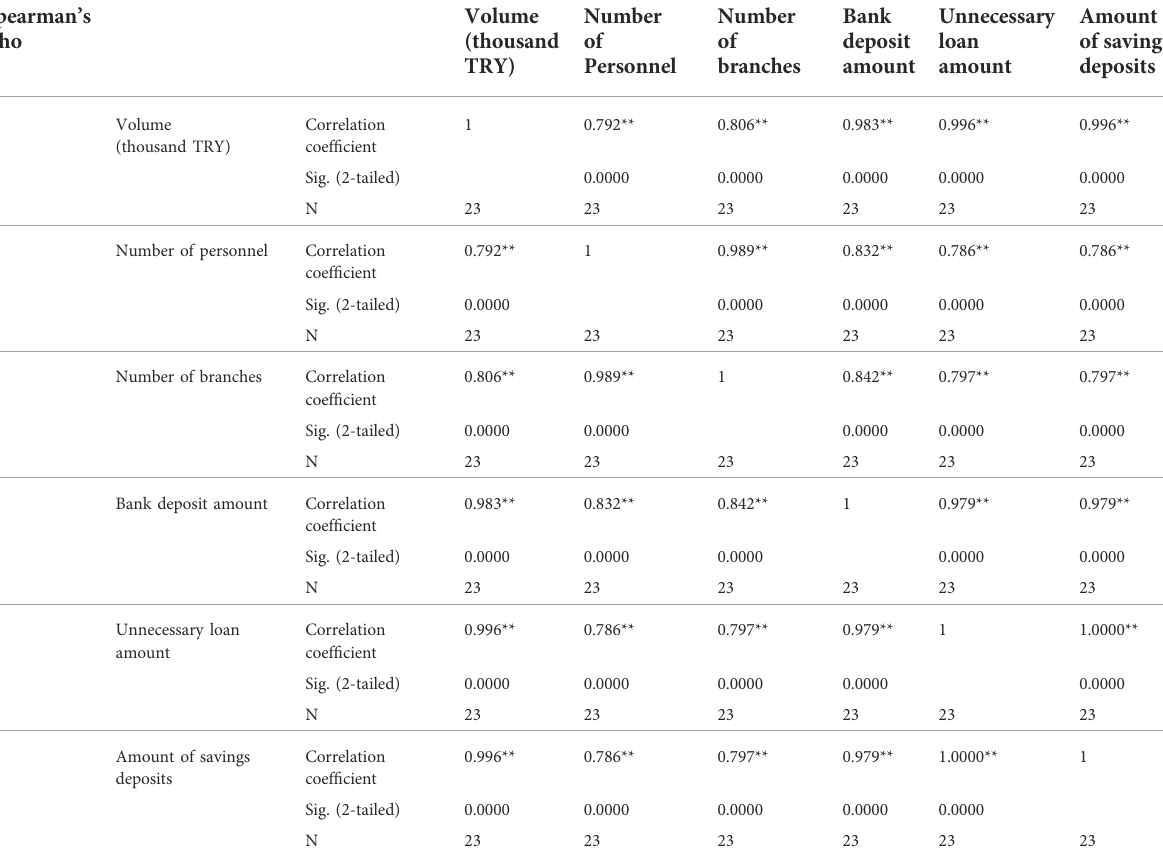
TABLE 13 Spearman ’ s correlation analysis on volume, number of personnel, number of branches, amount of deposits of banks, amount of extra- useless loans, and amount of savings deposits. Spearman ’ s